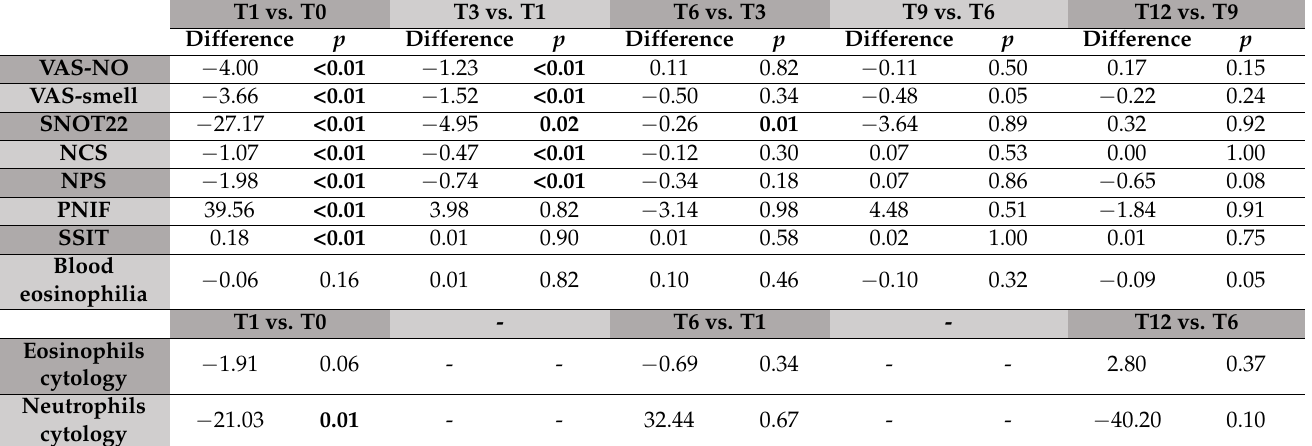
Table 2. Changes in the main clinical outcomes during the study period.